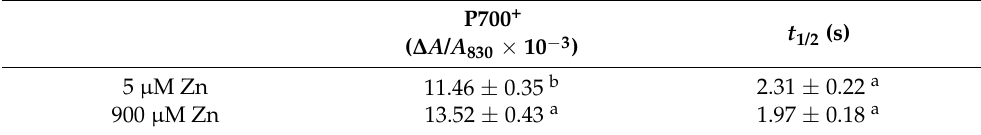
Different letters indicate significant differences between the mean values ( ± SE) for the same parameters ( p < 0.05).